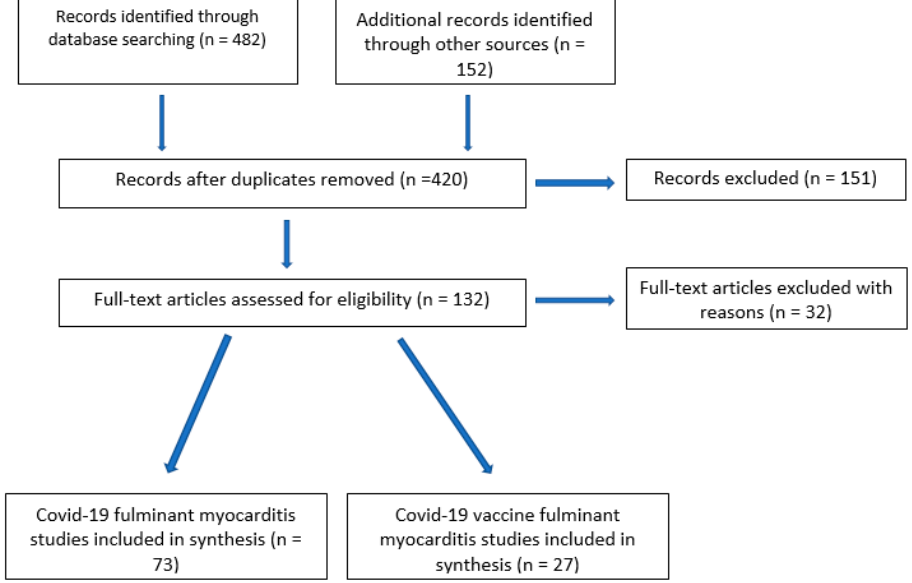
Figure 1. The literature search: the flow diagram.